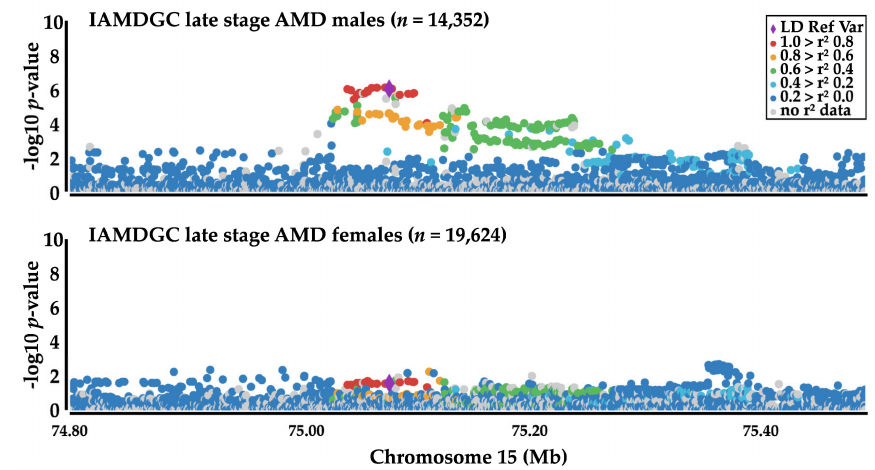
Figure 2. Association of rs2168518 with AMD in males and females. The association with late-stage AMD was calculated separately for both sexes in the IAMDGC dataset. While an association signal with AMD can be detected in males, an association in females is missing. Rs2168518 is presented as purple diamond and serves as linkage disequilibrium (LD) reference variant. Plots were created with Locuszoom [30]. n = sample